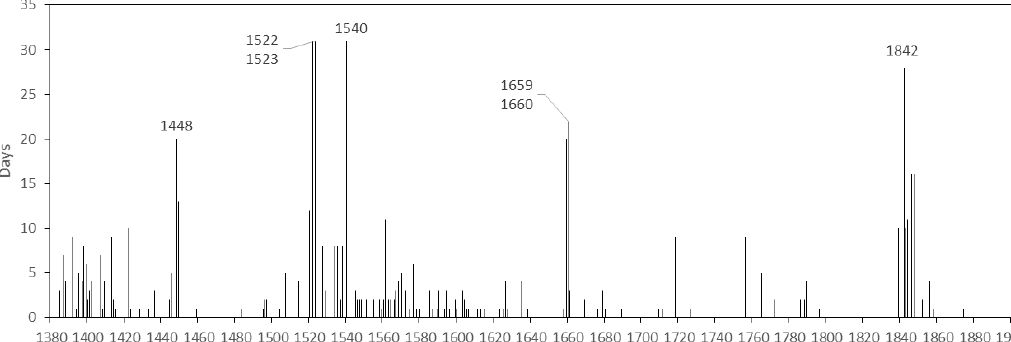
Figure 3. Mismatches between the Angot 1885 and Labbé-Gaveau 2011 Dijon GHD series (1385–1905).